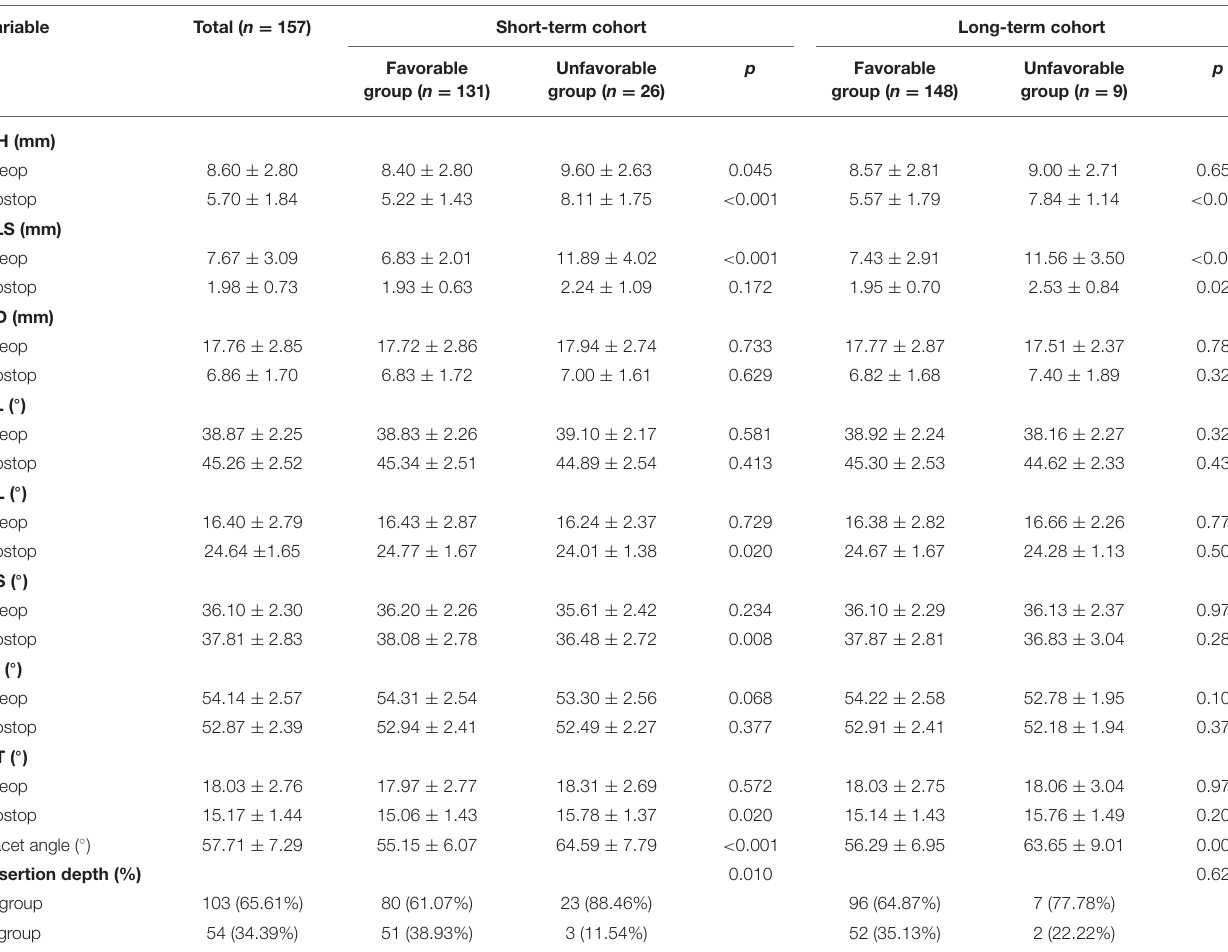
TABLE 3 | Comparison of the radiologic variables.